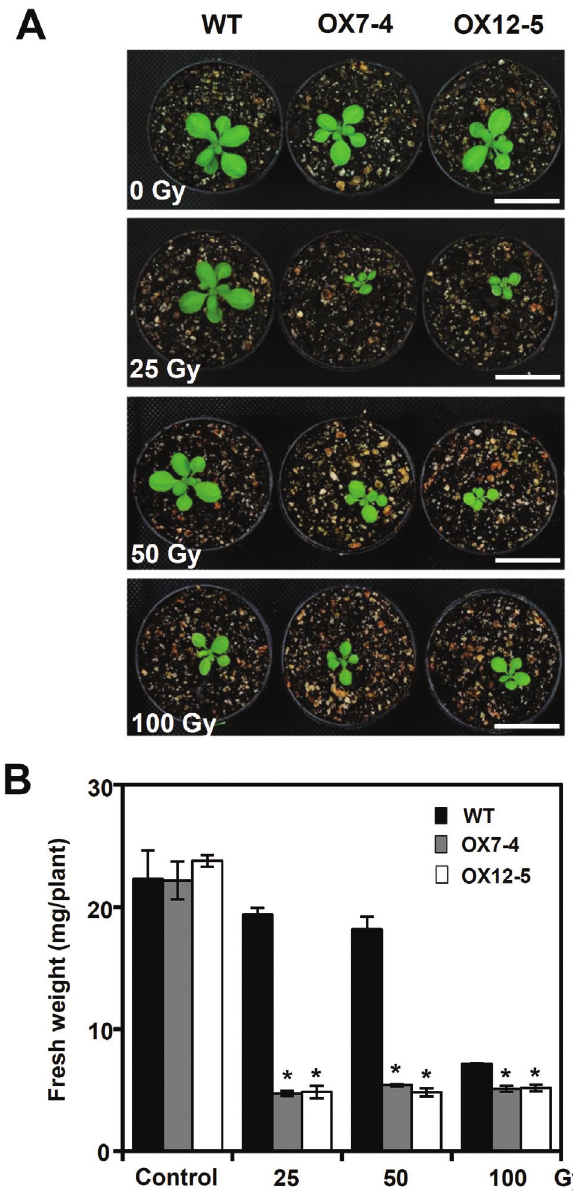
Figure 5 - Phenotype analysis of transgenic 35S: OsFBX322 plants. (A) Enhanced sensitivity of 35S: OsFBX322 plants. Two-week-old wild-type (WT) and 35S: OsFBX322 (OX7-4 and OX12-5) plants were exposed to gamma irradiation as indicated. Plants were photographed after 4 days re- covery under normal conditions. Scale bar = 2.5 cm. (B) Fresh weights of irradiated WT and transgenic plants. Average fresh weight was estimated from 3–5 plants. Data are means (cid:4) SE from at least three independent ex- periments. Asterisks indicate statistical significance ( p < 0.05, Student’s t -test) of differences between transgenic lines and